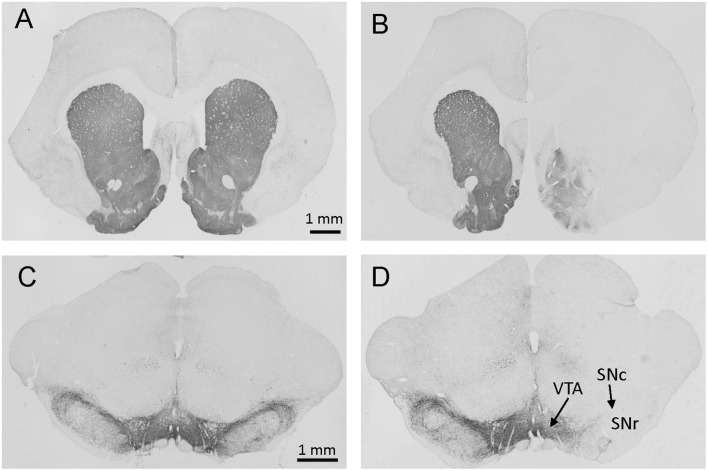
Photomicrographs of brain sections with tyrosine hydroxylase (TH) immunostaining at levels of the striatum (A,B) and substantia nigra (SN; C,D) from rats microinjected with vehicle (A,C) or 6-OHDA (B,D) in the right site of medial forebrain bundle (mfb). The immunostaining was processed about 6 weeks after mfb microinjection. Marked reductions in striatal fiber density (B) and nigral DA neurons (D) were shown on the side of 6-OHDA injection (right). SNc: substantia nigra pars compacta; SNr: SN pars reticulata; VTA: ventral tegmental area.